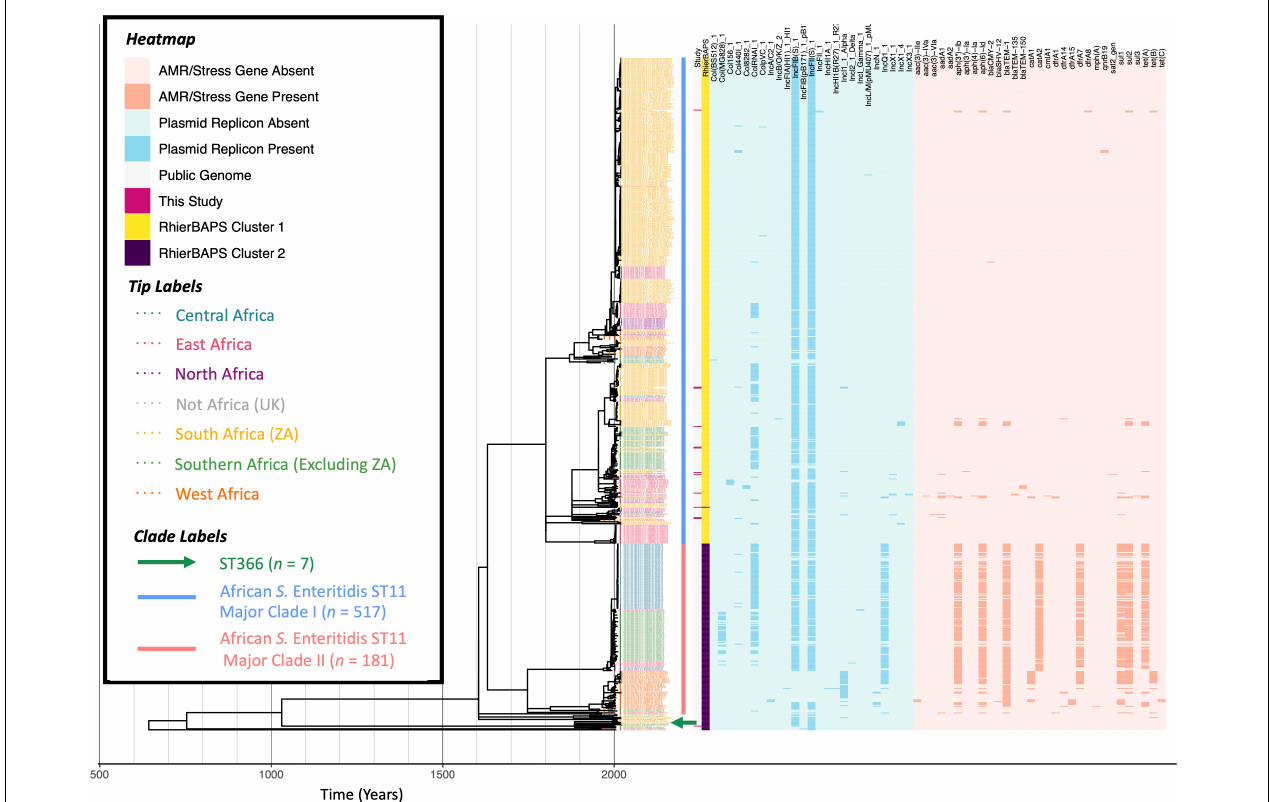
FIGURE 6 | Maximum likelihood phylogeny constructed using core SNPs identified among 716 African S. Enteritidis genomes (703 publicly available genomes, plus 13 sequenced here). Tip label colors denote the region/country from which each strain was reported to have been isolated (based on African regions as defined by the African Union, 25 April 2021). Clade labels shown to the right of the phylogeny tip labels denote major clades discussed in the main text. The heatmap to the right of the phylogeny denotes: (i) whether an isolate was sequenced in conjunction with this study (dark pink) or not (gray; “Study”); (ii) level 1 cluster assignments obtained using RhierBAPS (“RhierBAPS”); the presence and absence of (iii) plasmid replicons (blue) and (iv) antimicrobial resistance (AMR) determinants (orange). The phylogeny was rooted and time-scaled using LSD2, with branch lengths reported in years ( X -axis). Core SNPs were identified among all genomes using Parsnp. AMR determinants were identified using ABRicate, the NCBI AMR determinant database, and minimum identity and coverage thresholds of 75 and 50%, respectively. Plasmid replicons were identified using ABRicate and the PlasmidFinder database, using minimum identity and coverage thresholds of 80 and 60%, respectively. The phylogeny was constructed and annotated using IQ-TREE and bactaxR/ggtree,